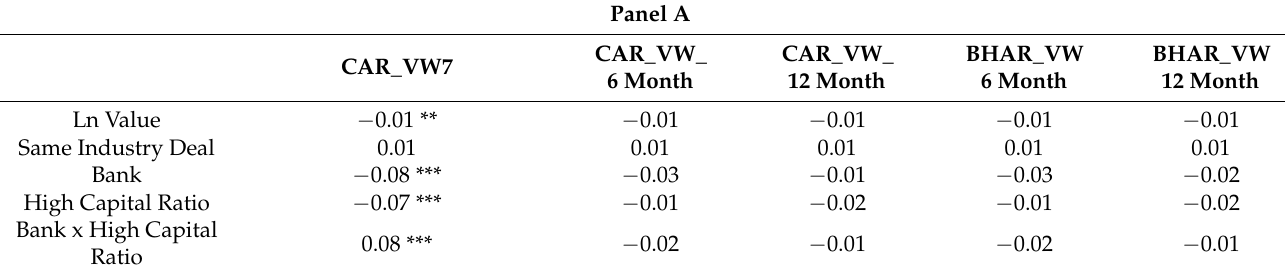
Table 4. Multivariate Analysis: Capital Ratio, Abnormal Returns, and Performance. This table reports the regression coefficients and their significance based on firm-clustered adjusted t-statistics, as well as the adjusted R 2 statistic of specifications explaining the announcement period abnormal returns, longer-run post-announcement abnormal returns, and longer-run post-acquisition performance, where the bank dummy variable and the interaction term of the bank dummy variable with a high capital ratio dummy variable are the main explanatory variables. Year and industry fixed effects as well as several deal-specific control variables are included. Heteroscedasticity test p -values, Durbin–Watson test statistics and t-statistics of error terms are reported below the adjusted R 2